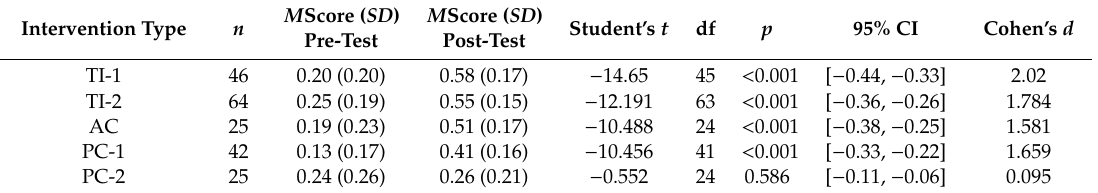
Table 3. Results of paired samples t tests examining the di ff erence between participants’ performance in pre- and post-test as a function of the type of intervention.